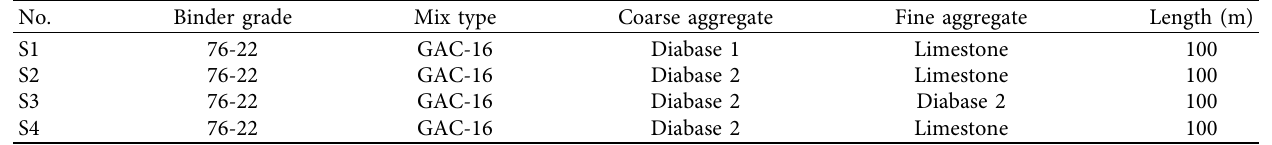
Table 1: Antiskidding surface layer scheme.